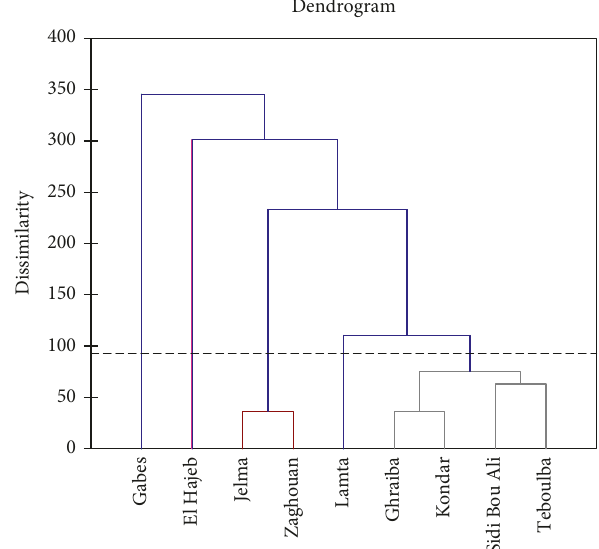
Figure 8: Hierarchical cluster analysis dendrogram. Groups: (1) Gabes; (2) Ghraiba, Kondar, Sidi Bou Ali, Teboulba; (3) El Hajeb; (4) Jelma, Zaghouan; (5)